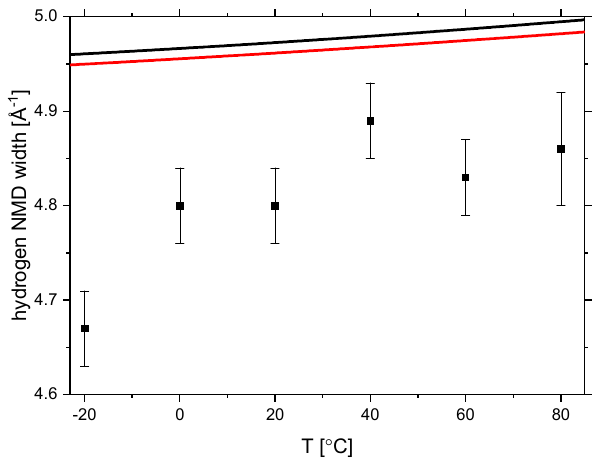
Figure 11. The NMD widths of hydrogen obtained from NCS experiments for the sample of rice pasta with the water content 0.1069 g/g d.m. between − 20 and 80 ◦ C. The thick black line represents the NMD width computed based on the AFGA model for a polymer of α -glucose units, (C 6 H 10 O 5 ) n . The thick red line represents the NMD width computed based on the AFGA model for a mixture of a polymer of α -glucose units, (C 6 H 10 O 5 ) n and water, C 6 H 10 O 5 (H 2 O) 1.1